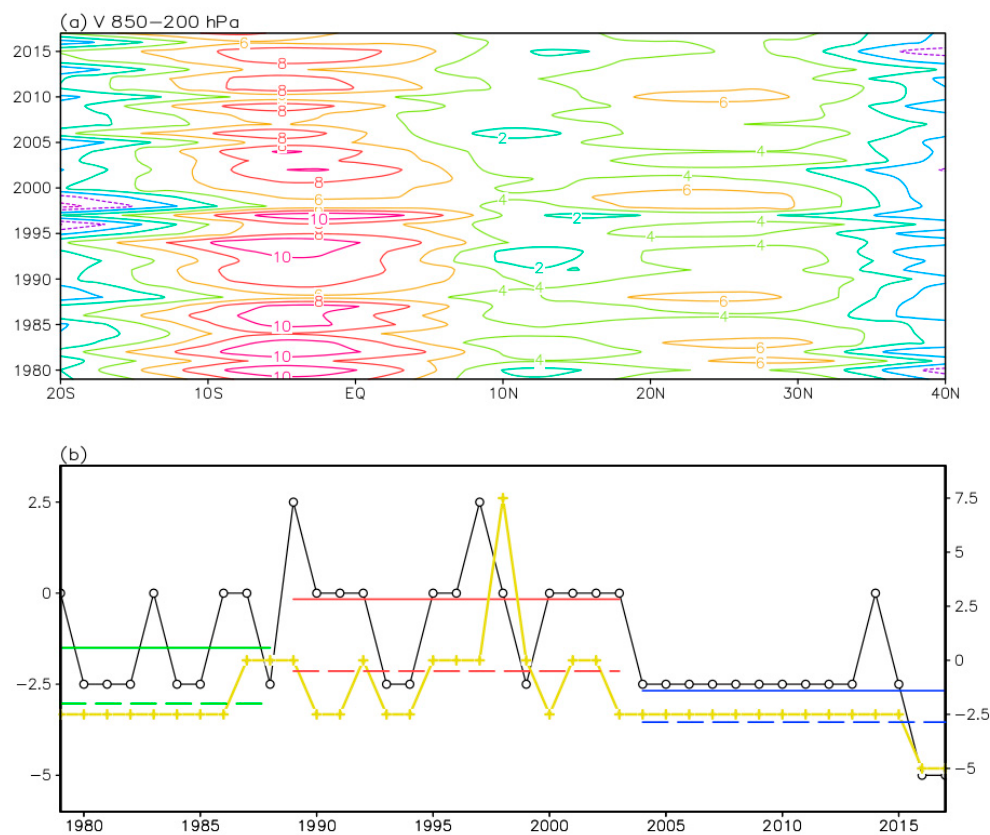
Figure 7. ( a ) Zonally averaged (125 ◦ E–155 ◦ E) vertical meridional wind shear between 850 and 200 hPa during 1979–2019 (unit m / s); ( b ) The black line represents the location of the maximum meridional wind at 850 hPa from 10 ◦ S–10 ◦ N (left ordinate denotes latitude, unit ◦ ), the yellow line represents the location of maximum vertical meridional wind shear between 850 and 200 hPa ranging from 10 ◦ S–10 ◦ N (right ordinate denotes latitude, unit ◦ ). The green line represents the average location of the maximum meridional wind at 850 hPa and maximum vertical meridional wind shear between 850 and 200 hPa during P1; red and blue lines are the same as the green line, but they represent P2 and P3, respectively.